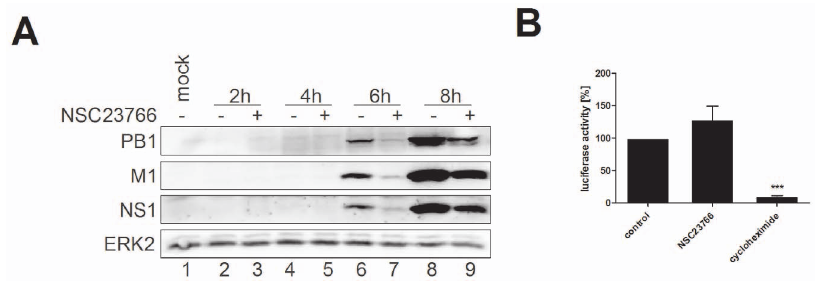
Figure 4. Inhibition of Rac1 by NSC23766 leads to reduced synthesis of viral proteins. (A) A549 cells, infected with A/Puerto-Rico/8/34 rec. (moi=5), were treated with NSC23766 (100 m M) 30 min p.i.. Cell lysates were prepared at the indicated times and subjected to Western blot analysis. The viral protein synthesis was monitored by PB1, M1, and NS1 detection and visualization of ERK2 served as a loading control. (B) A549 cells were transfected with a constitutively active CMV promoter luciferase plasmid for six hours. Subsequently, NSC23766 was added at a concentration of 100 m M. Untreated cells served as a negative control, while cycloheximide treatment (10 m g/ml) was used as a positive control. After 24 h incubation, cells were subjected to luciferase assay. Data represent means 6 SD of three independent experiments including three biological samples. Statistical significance was evaluated with Student’s t -test (*** p , 0.001).